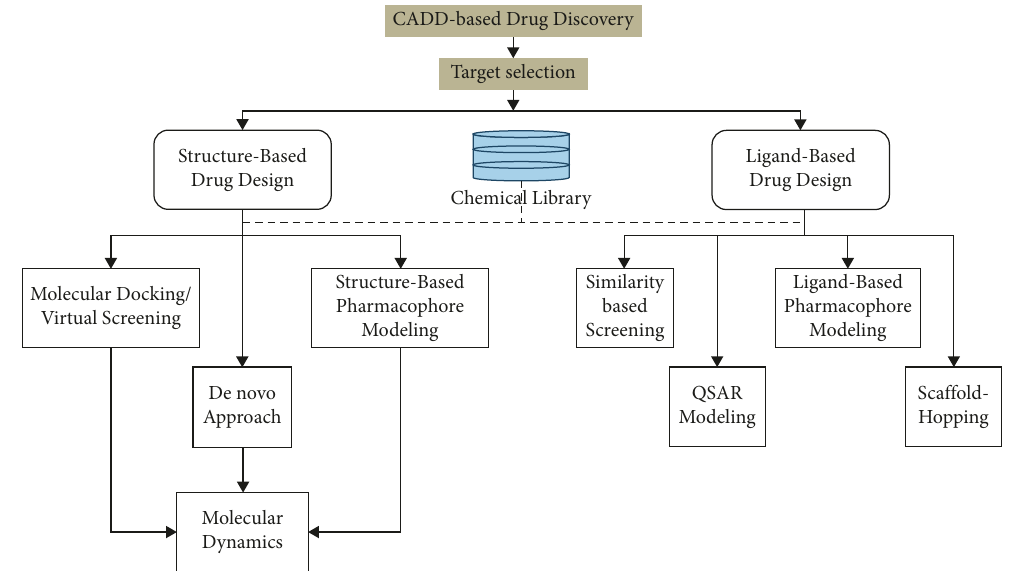
Figure 1: Computational methods in drug design (CADD: computer-aided drug